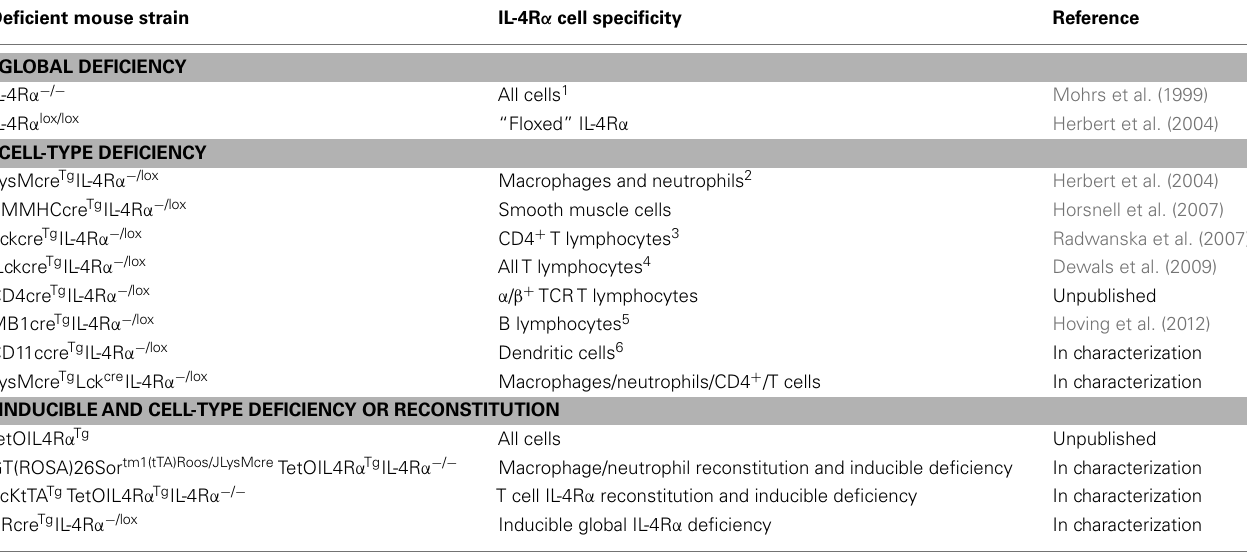
Table 1 | Global and conditional IL-4R α gene-deficient mouse models currently available or being characterized. Deficient mouse